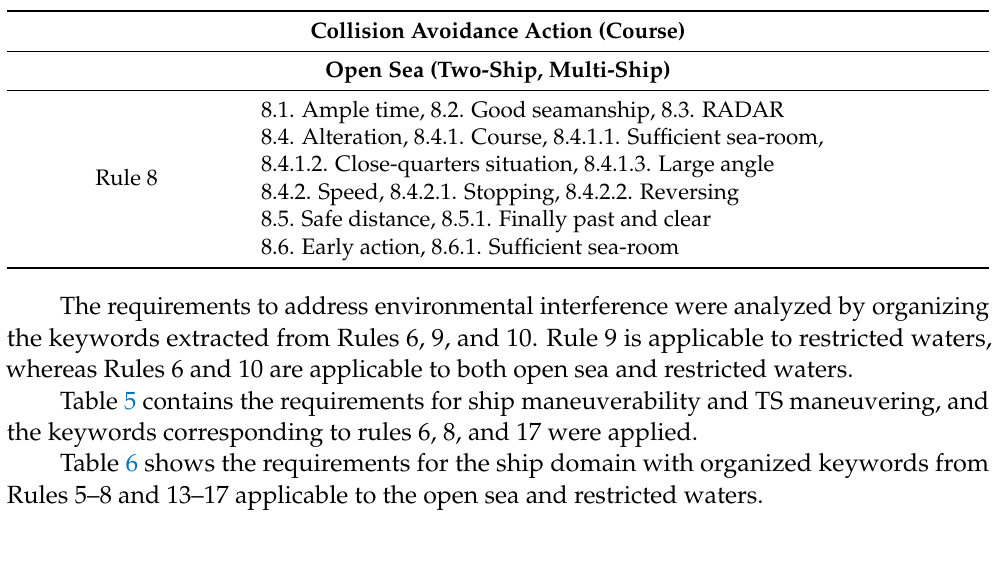
Table 9. Requirements analysis of collision avoidance action